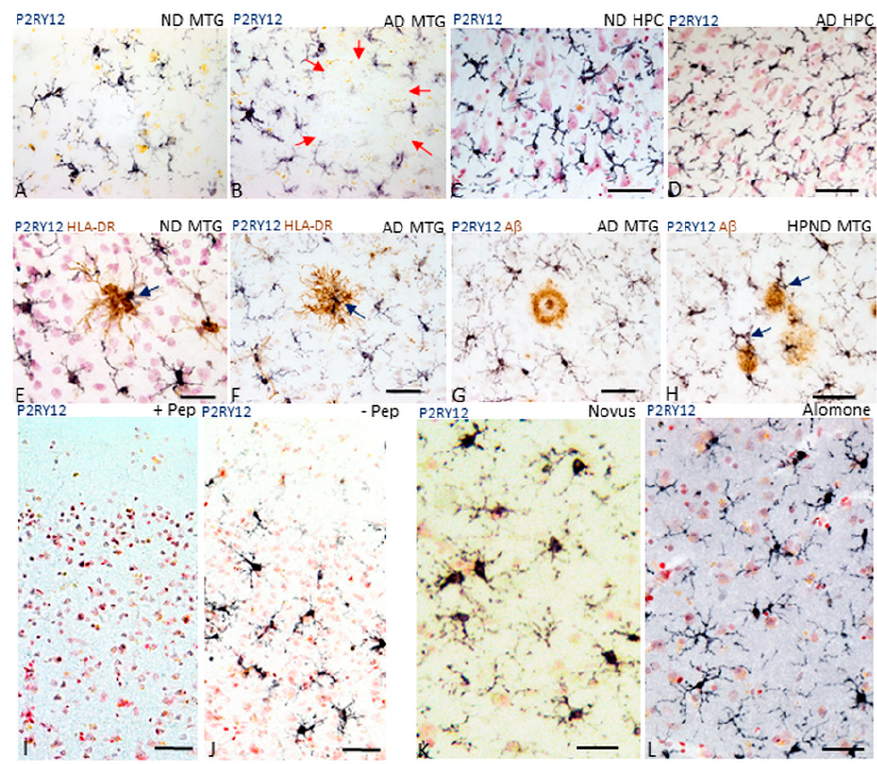
Figure 1. Features of P2RY12-immunoreactive microglia. ( A , B ). Morphology of P2RY12-immunoreactive microglia (purple) in a low plaque non-demented (LPND) case ( A ) and AD case ( B ). Sections of middle temporal gyrus (MTG) were single-stained with antibody to P2RY12. Red arrows in panel B illustrate the lack of P2RY12 immunoreactive cells in an area occupied by plaque. ( C , D ). P2RY12-immunoreactive microglia (purple) are a feature in hippocampus sections from non-demented (ND) case ( H ) and Alzheimer’s disease (AD) case. Section shows staining in CA2 region of hippocampus. Continued presence of P2RY12-positive microglia in AD hippocampus ( D ) was noticeable. ( E , F ). Double-staining of section of ND and AD case with P2RY12 (purple) and HLA-DR (brown) showed limited overlap. HLA-DR-positive microglial clusters over plaques were P2RY12-negative except for single cells observed within the cluster (arrows). ( G , H ). Interaction of P2RY12-immunoreactive microglia (purple) and A β plaques (brown). The panels show two types of interactions of P2RY12-positive microglia with plaques. Positive microglia are not present in close association with mature cored plaque ( G ), while they are present in close association with di ff use type of plaques ( H ). Specificity controls for P2RY12 staining of microglia. ( I , J ). Staining of representative sections with P2RY12 (Novus) antibody preabsorbed with immunizing peptide (I, + Pep) compared to staining of matched section with P2RY12 antibody non-absorbed ( J , -Pep). ( K , L ). Staining of matched sections with alternative P2RY12 antibody. Same staining pattern of microglia revealed with P2RY12 (Novus) antibody ( C ) as with P2RY12 (Alomone Labs) antibody (D ). Sections reacted with Alomone Lab P2RY12 required antigen retrieval to obtain positive staining pattern. All sections shown had been counterstained with neutral red to identify nuclei (red color). Abbreviations: ND: non-demented. AD: Alzheimer’s disease. MTG: middle temporal gyrus.—Pep: antibody without immunizing peptide. + Pep: antibody with immunizing peptide. Scale bars represent 50 μ m.